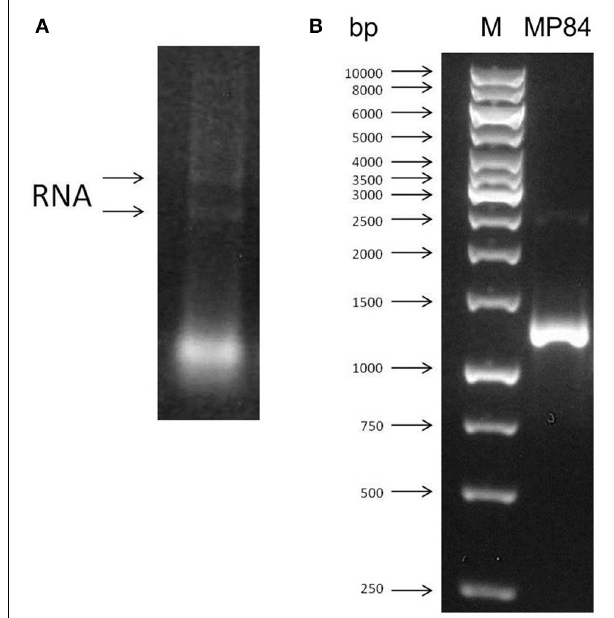
FIGURE 1 | RNA extraction and amplification of MP84 gene. (A) Ethidium bromide-stained 1% agarose gel of total RNA (0.5 μ g) extracted from C . neoformans CAP67. (B) PCR fragment amplified using specific oligonucletides for MP84. (M) Markers